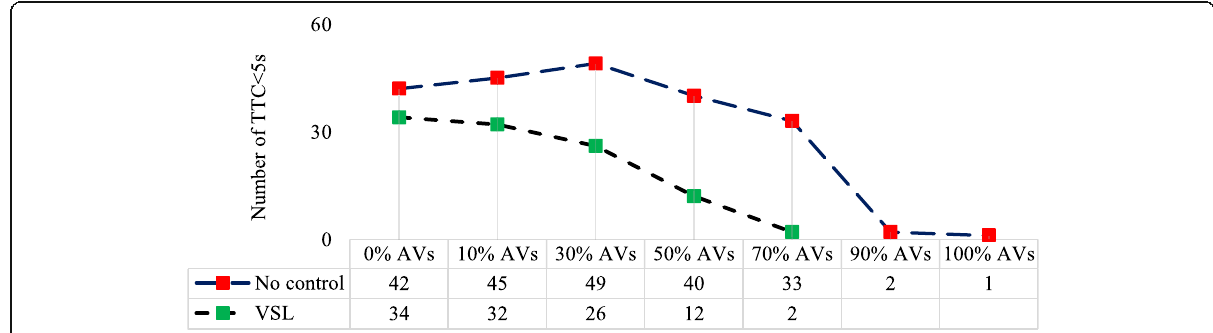
Fig. 4 The number of TTC< 5 s under heavily congested Traffic